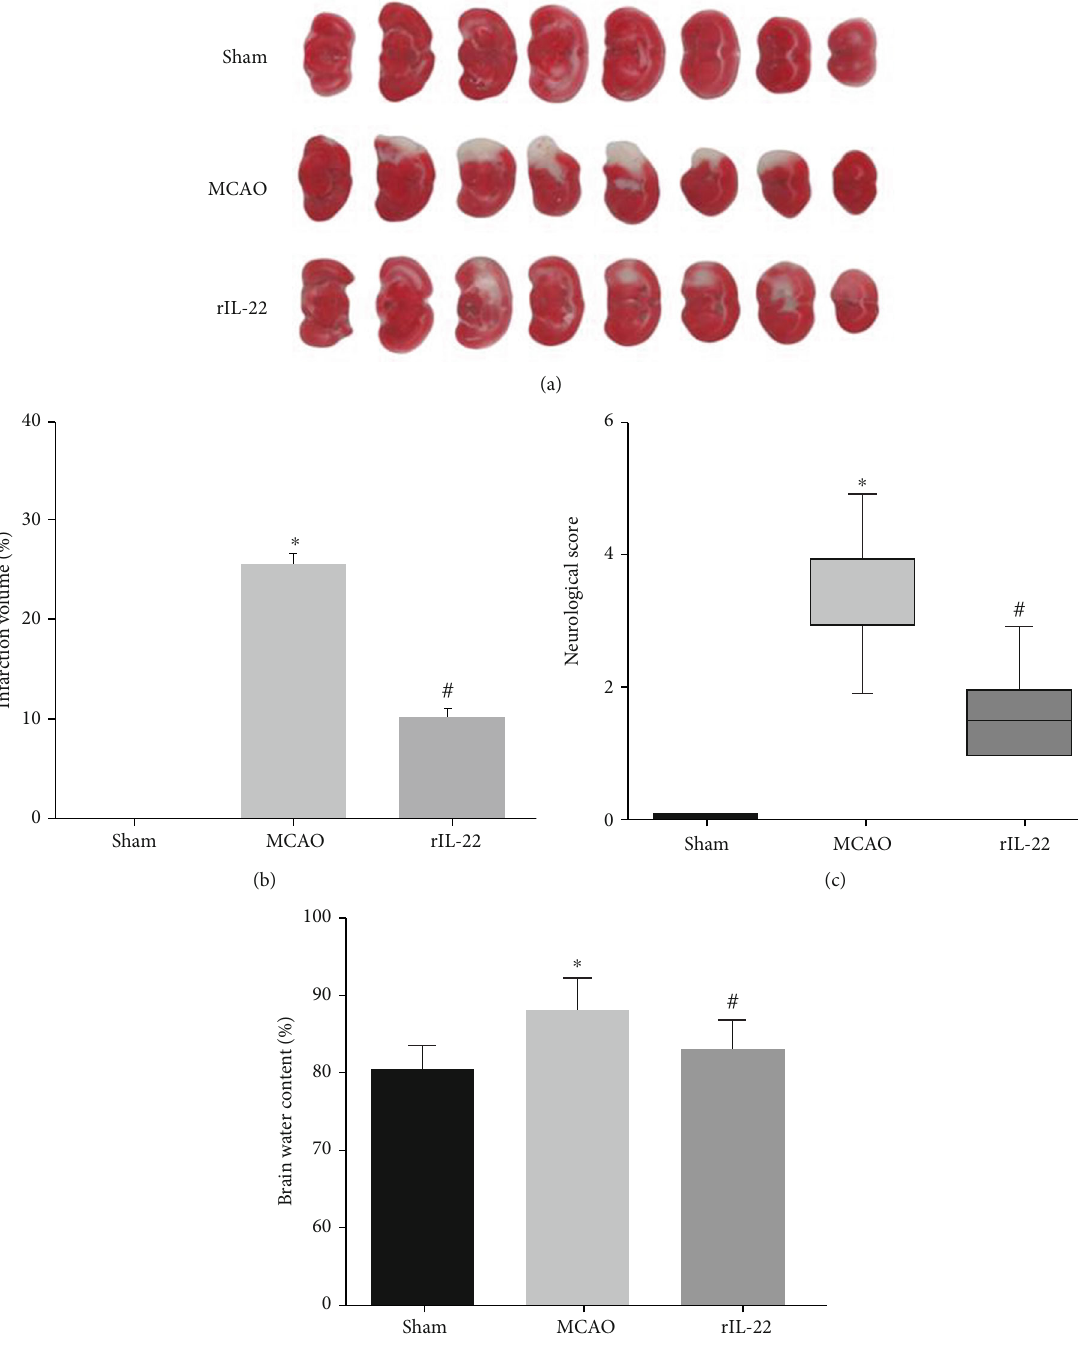
Figure 1: IL-22 treatment ameliorated cerebral I/R injury. (a) Representative sections of TTC staining in each group ( n = 6 ). (b) Quanti fi cation of infarct volume in each group ( n = 6 ). (c) Neurological de fi cits were assessed in each group ( n = 8 ). (d) Brain water content was calculated in each group ( n = 6 ). ∗ P < 0 : 05 vs sham group; # P < 0 : 05 vs MCAO